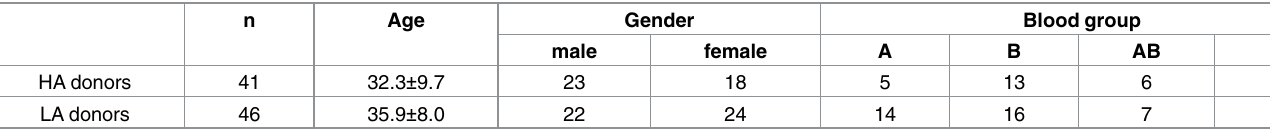
Table 1. Demographics of blood donors in this study.